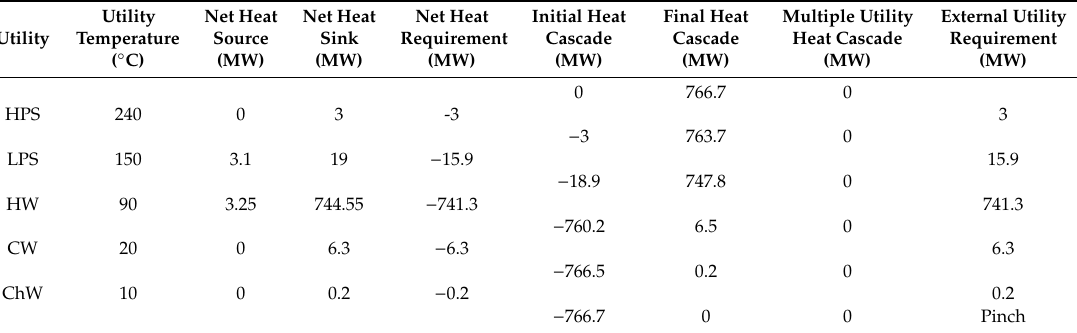
Table 9. TS PTA for all industrial plants from 17 to 20 h.